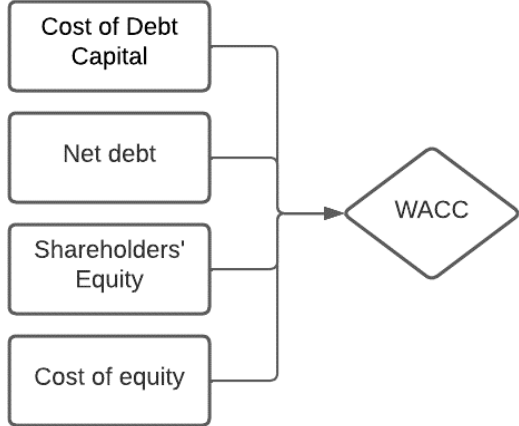
Figure 1. Structure of the WACC formation.